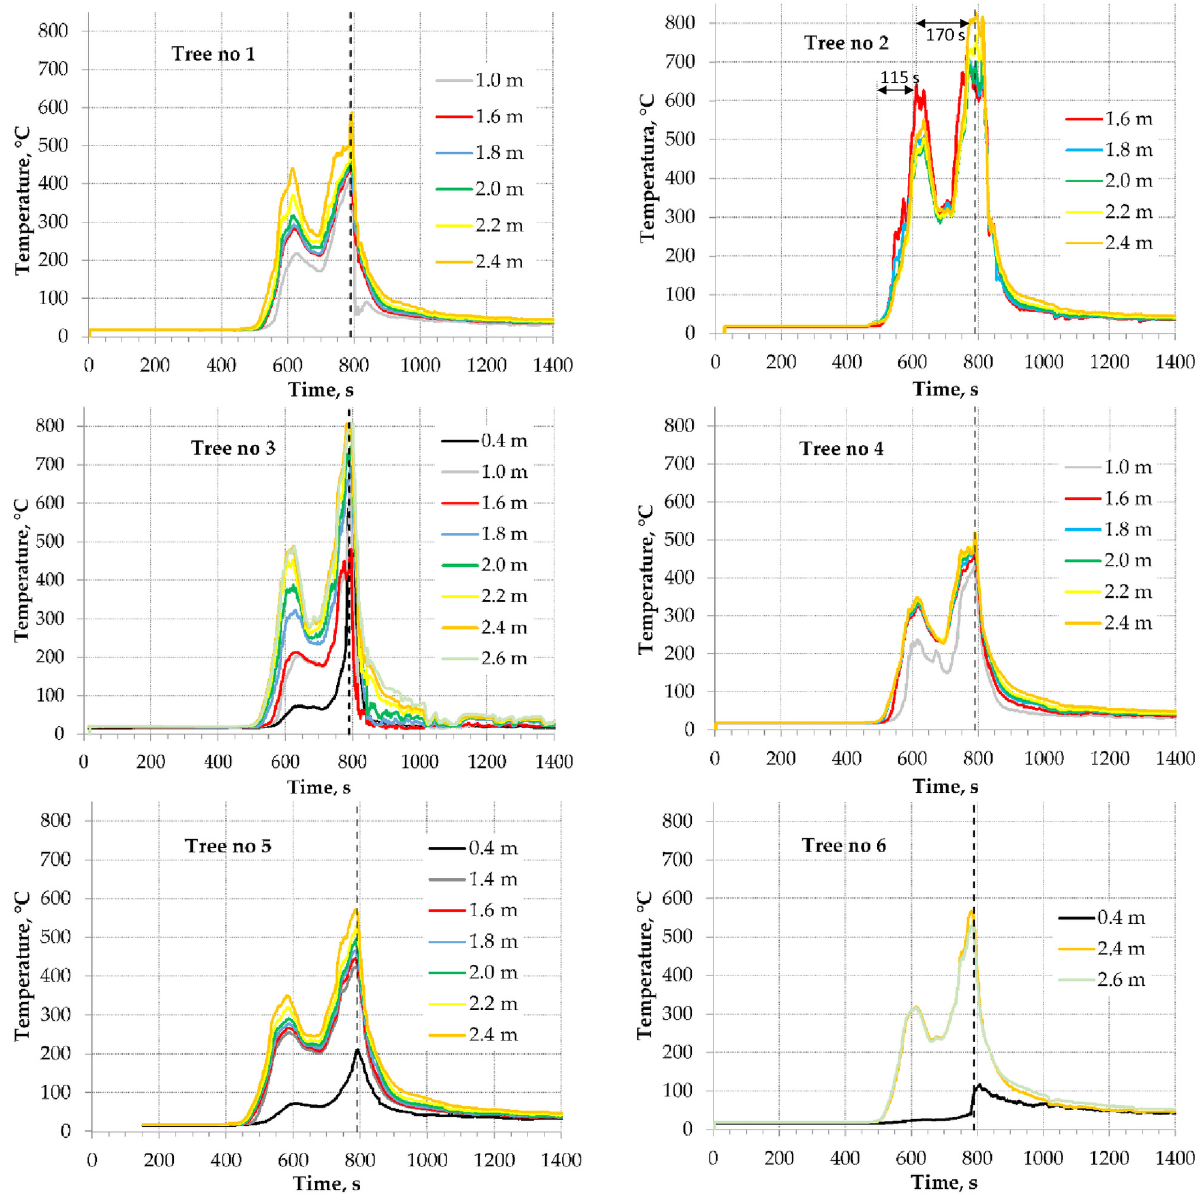
Figure 5. Temperatures during the first test. Dashed lines mark the beginning of the firefighting operations (790 s).